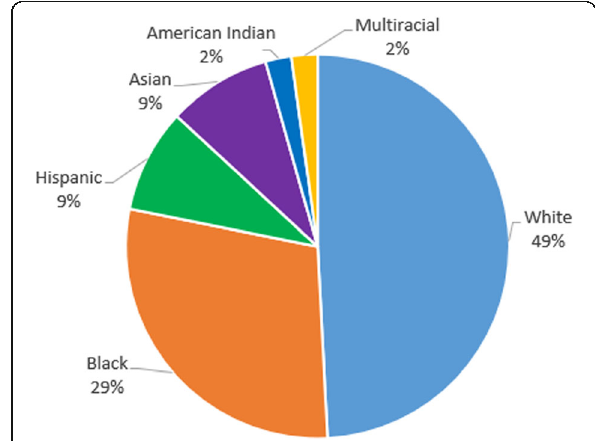
Fig. 1 Demographics of interviewed students. Demographics deviated from those in STEM but closely match the demographics of the geographic location in which interviews were conducted. Note that White and Black students made up the two largest demographic